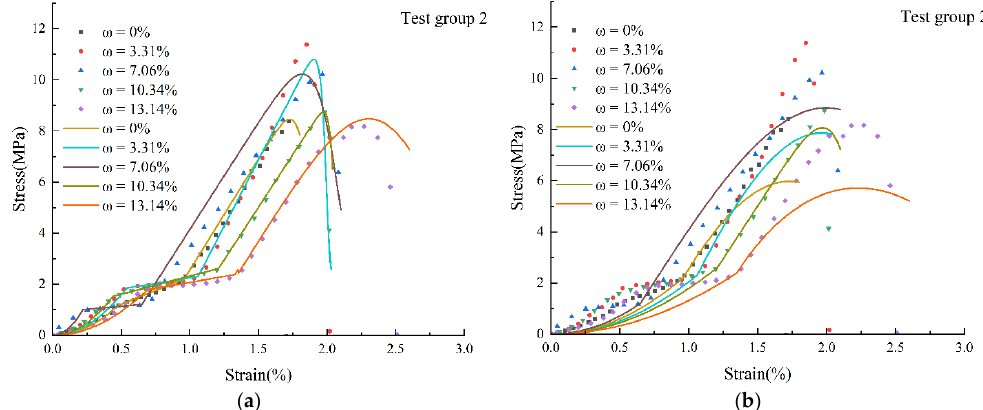
Figure 9. The uniaxial compression test data points and theoretical model curve of coal samples in test group 1: ( a ) the author’s model; ( b ) the comparison model.